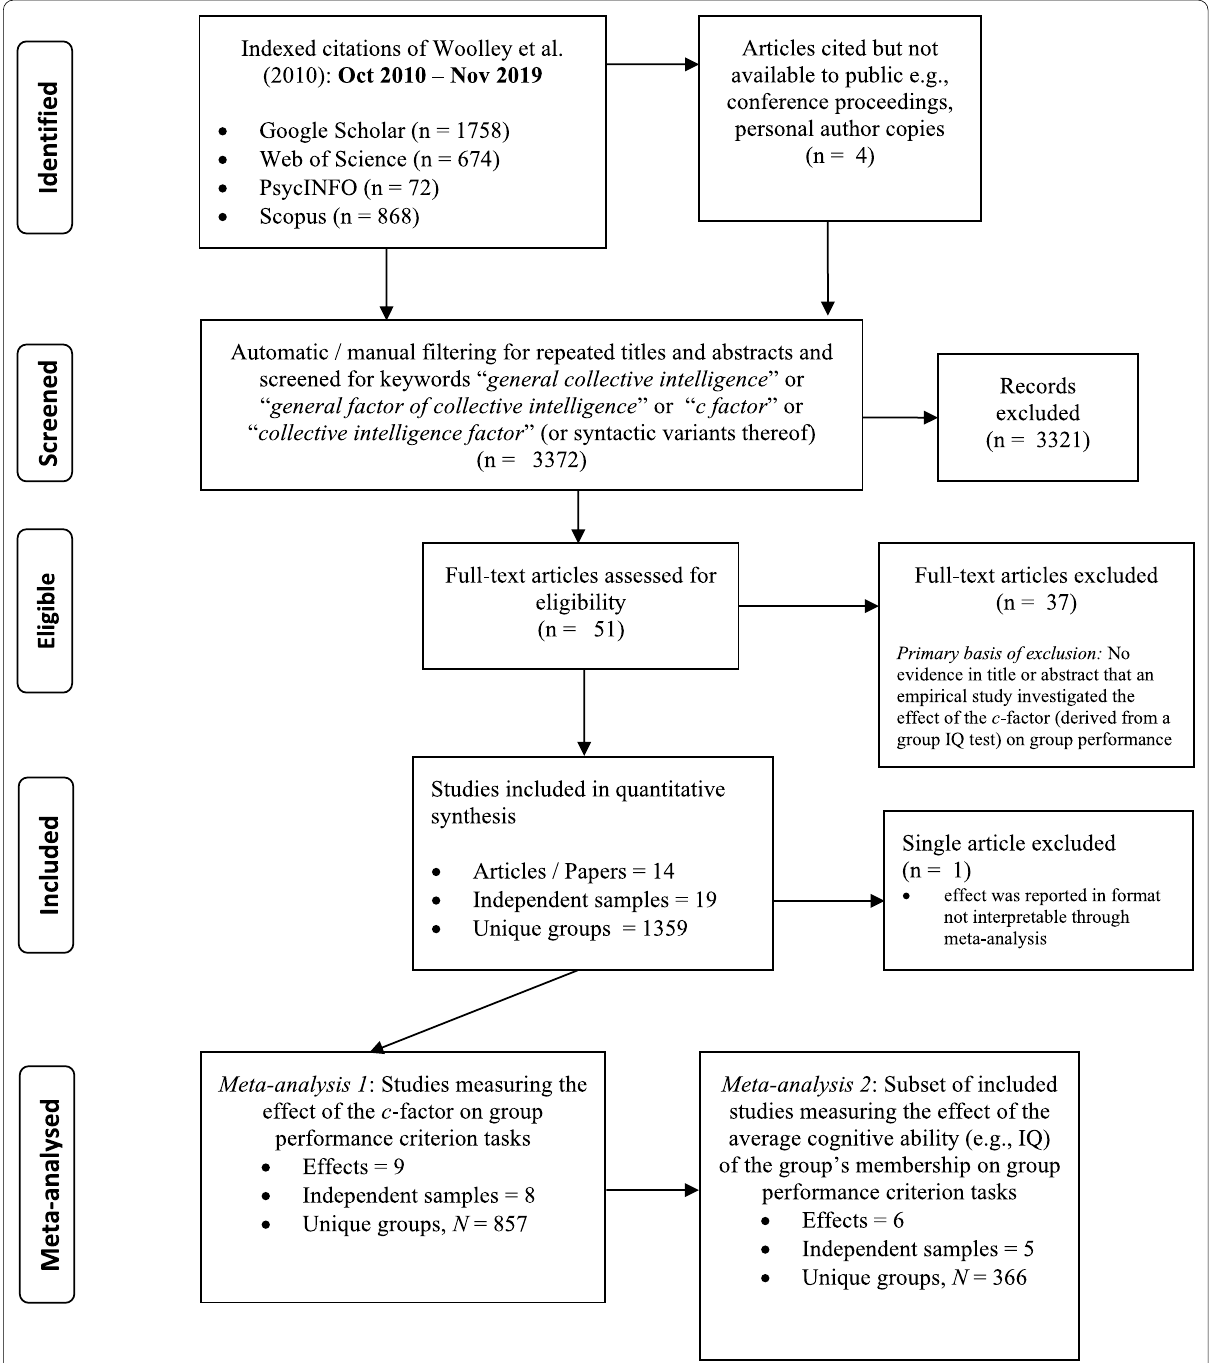
Fig. 1 Flow Diagram for Study Inclusion/Exclusion. Note. Citations were searched within indexed citations of the original article by Woolley et al. (2010) “Evidence for a Collective Intelligence Factor in the Performance of Human